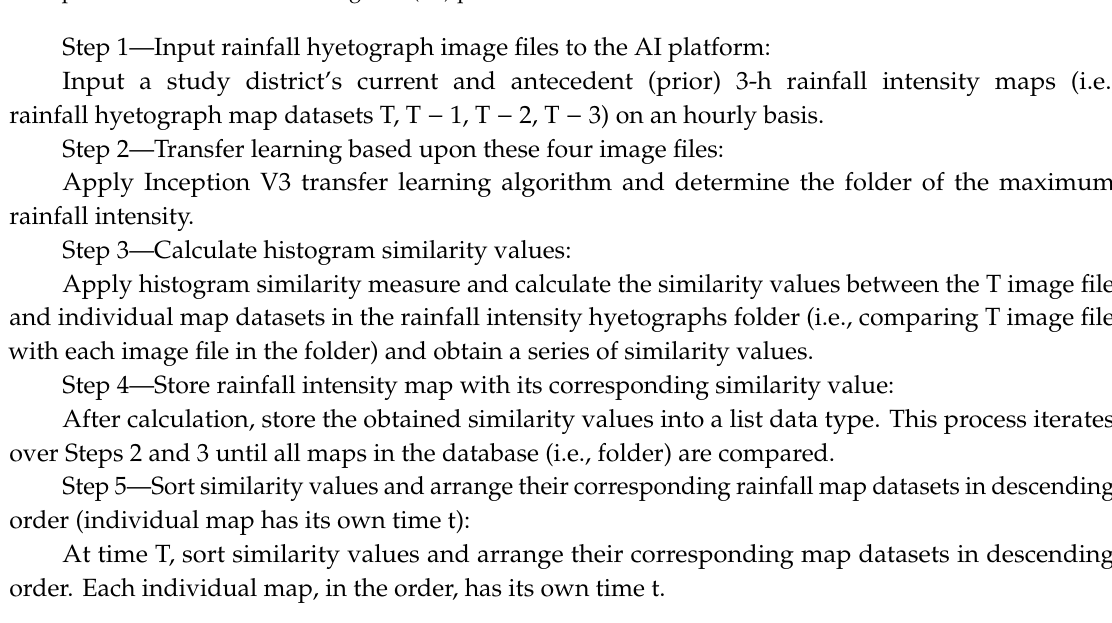
Figure 8. A scenario of rainfall intensity hyetograph converting into a color-classified image dataset and retrieving its corresponding flood map dataset in real-time.